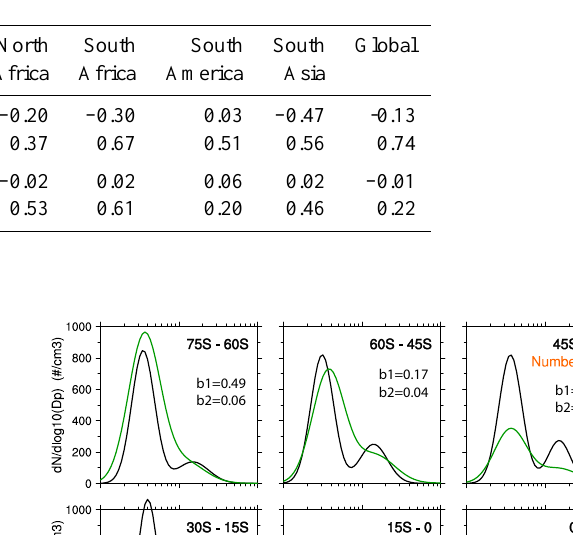
Table 7. Normalized mean biases (b) and correlation coefficients (R) between the model and observations for AOD and SSA over the seven regions included in Fig. 22.